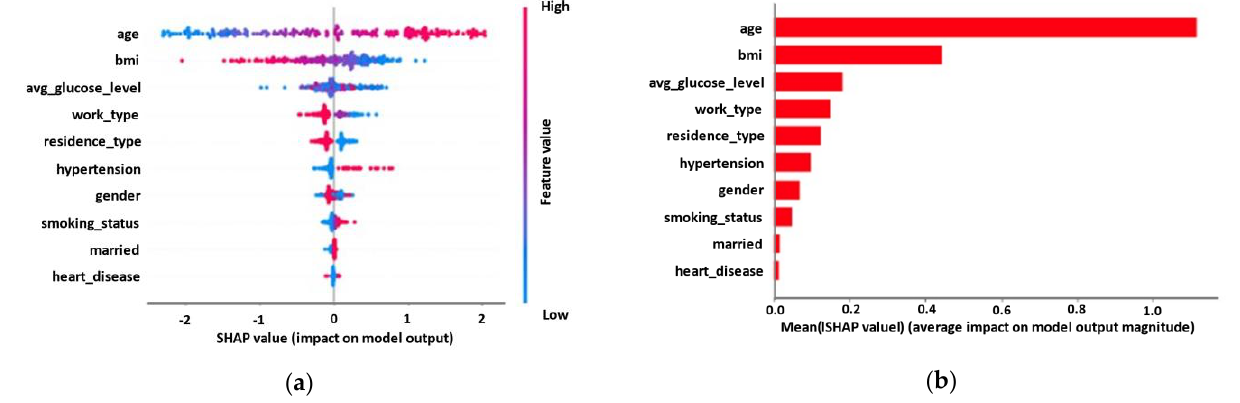
Figure 5. Risk factors’ impact on MLP model output for the cerebral stroke prediction dataset. ( a ) The distribution of the impact of a risk factor value on the model output across test instances. ( b ) The average impact magnitude for test instances.